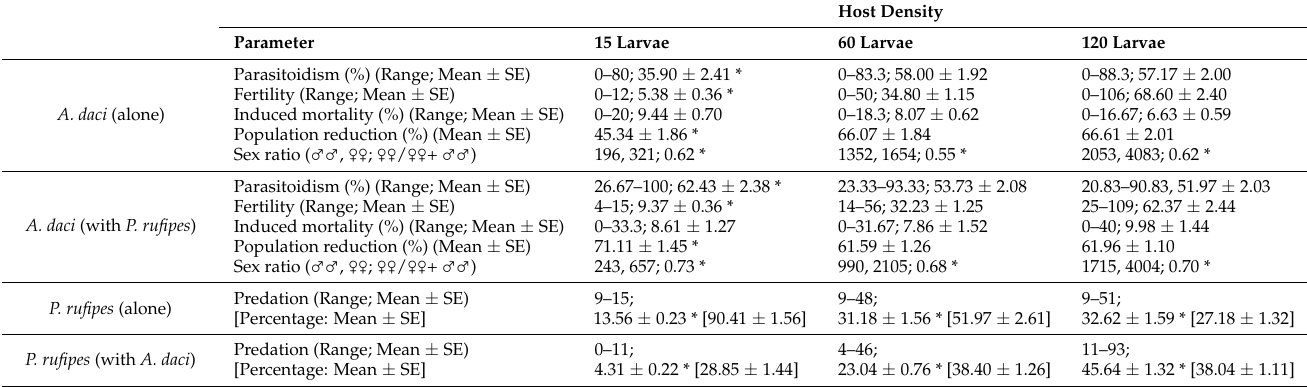
Table 4. Demographic parameters of A. daci (percentage parasitoidism, fertility, induced mortality, population reduction and offspring sex ratio) and P. rufipes (predation) acting alone and together under laboratory conditions on different host densities of C. capitata larvae. In each column, asterisk indicates significant differences for a same